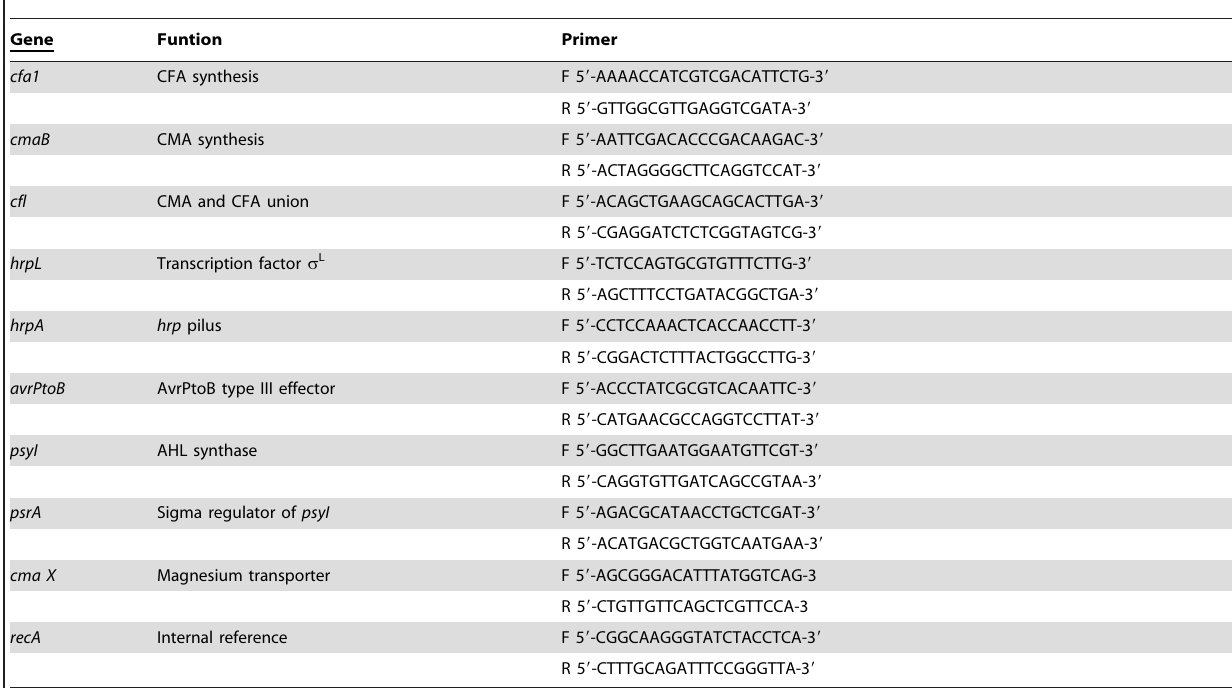
Table 1. Primers used for Real-Time